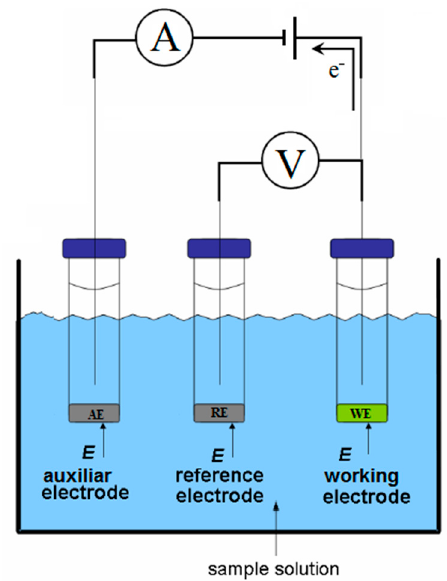
Figure 3. Setup of an amperometric sensor, where is applied to a potential difference between the working and reference electrodes, whilst the faradaic electric current is measured as long it flows towards the auxiliary electrode.